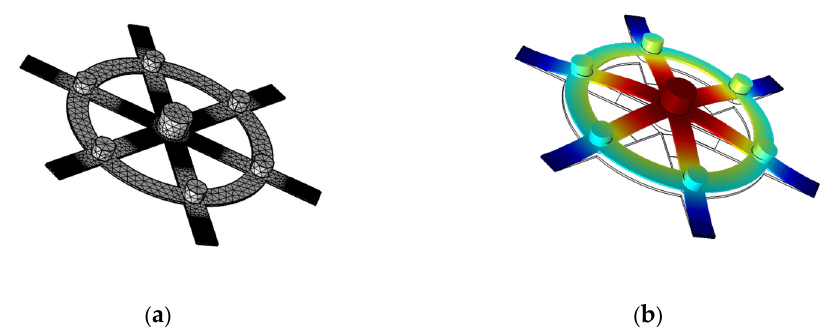
Figure 4. The finite element method (FME) results of the SR-PEH. ( a ) Meshing; ( b ) First-order mode of